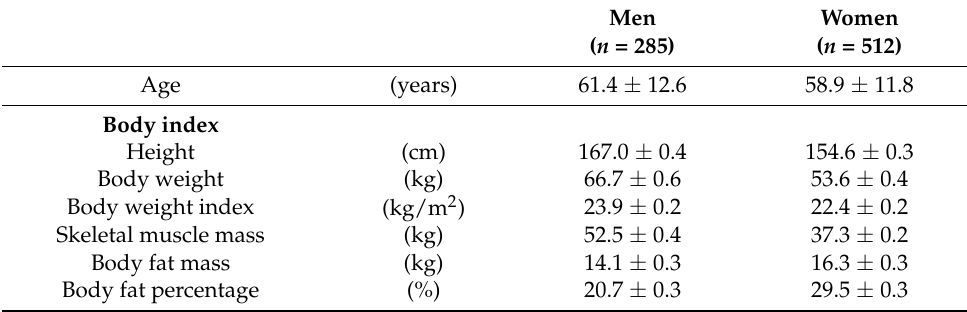
Table 1. Physical characteristics †